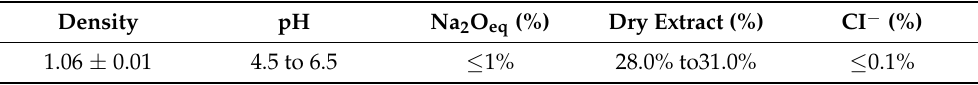
Table 1. Physicochemical characteristics of the SP.